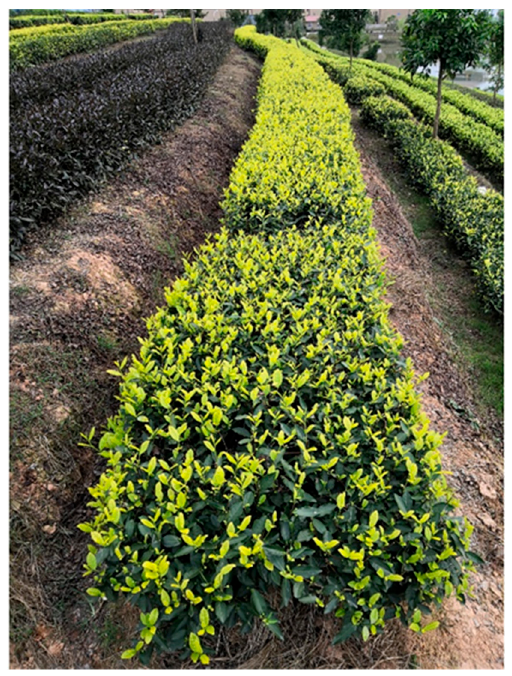
Figure 2. Source of measurement samples.